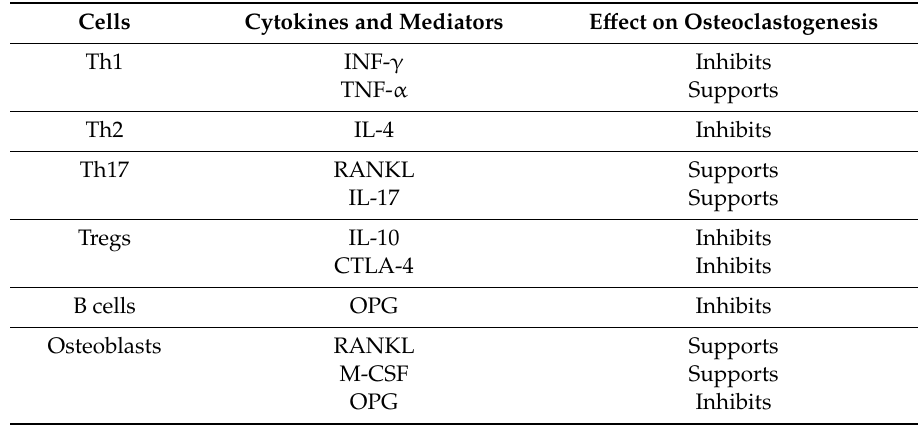
Table 1. Major cytokines and osteoclastogenic mediators secreted by T cells and B cells that mediate bone resorption during infection. (RANKL = receptor activator of NF- κ B ligand, OPG = osteoprotegerin, M-CSF = macrophage-colony-stimulating